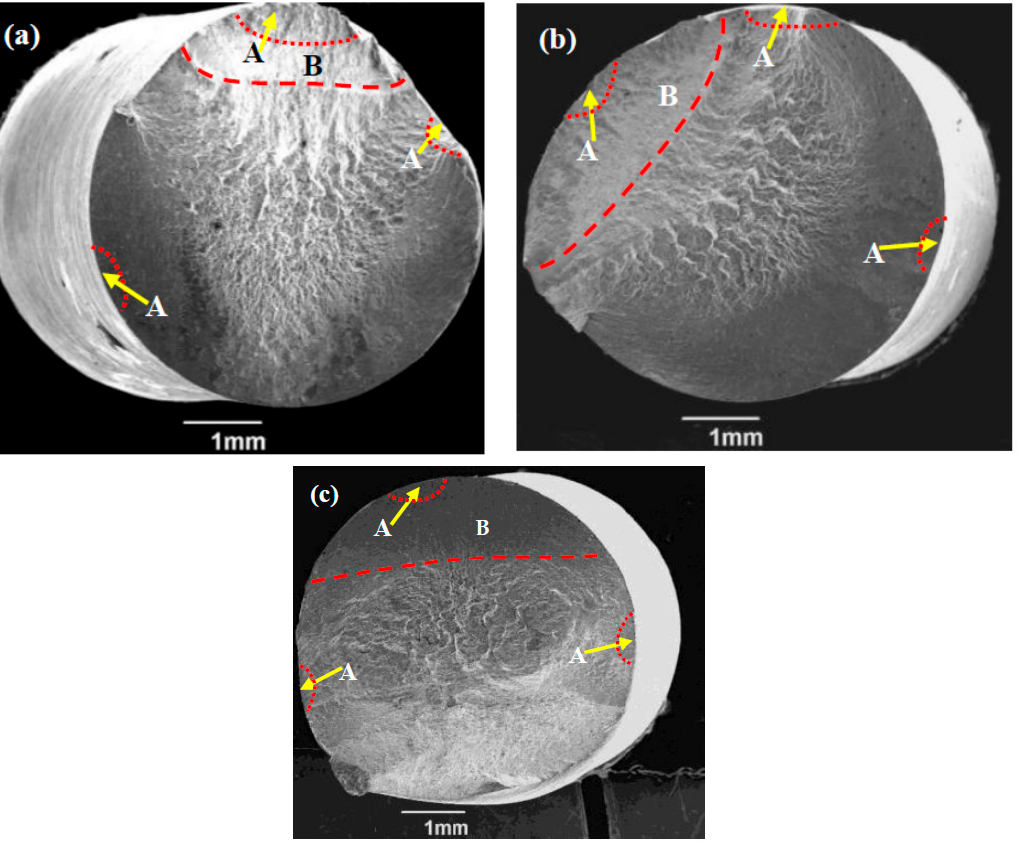
Figure 10. Macroscopic fatigue fracture morphologies of different stress amplitudes under 90° non- proportional tension–torsion loading. ( a ) S eq = 458.6 MPa, ( b ) S eq = 509.6 MPa, ( c ) S eq = 622.4 MPa. ‘A’ represents fatigue initiation zone and ‘B’ represents fatigue crack propagation